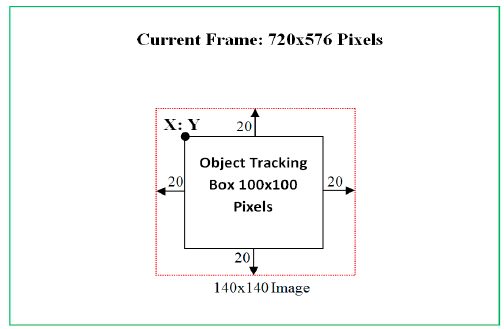
Figure 5. Location of the 140 × 140 pixel size image with reference to the tracked object.